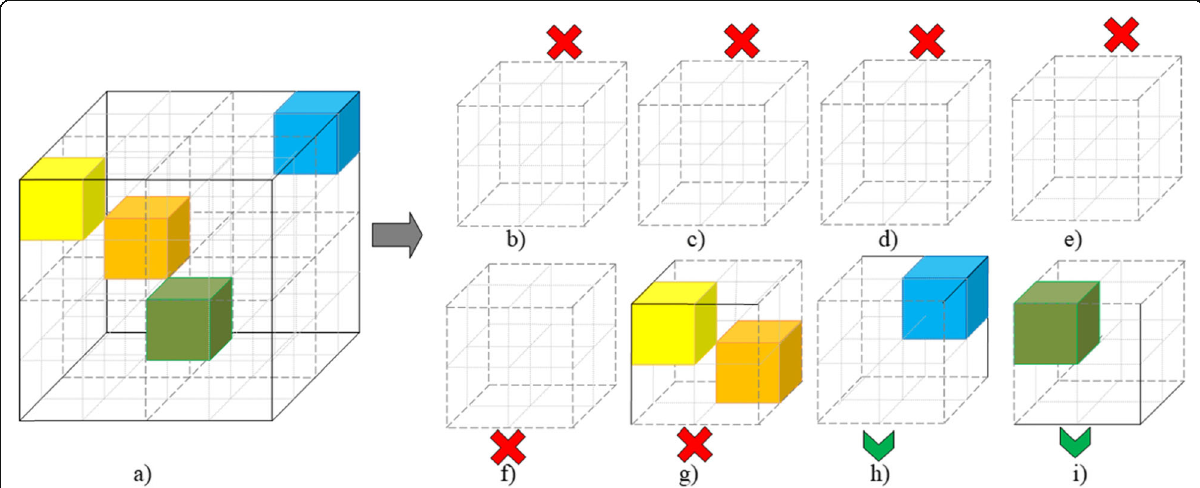
Fig. 3 Changed RGB cube ( a ), which was composed of all sub-cubes. Only sub-cubes h and i were suitable for embedding, while sub-cubes from b – g were left as it is, not